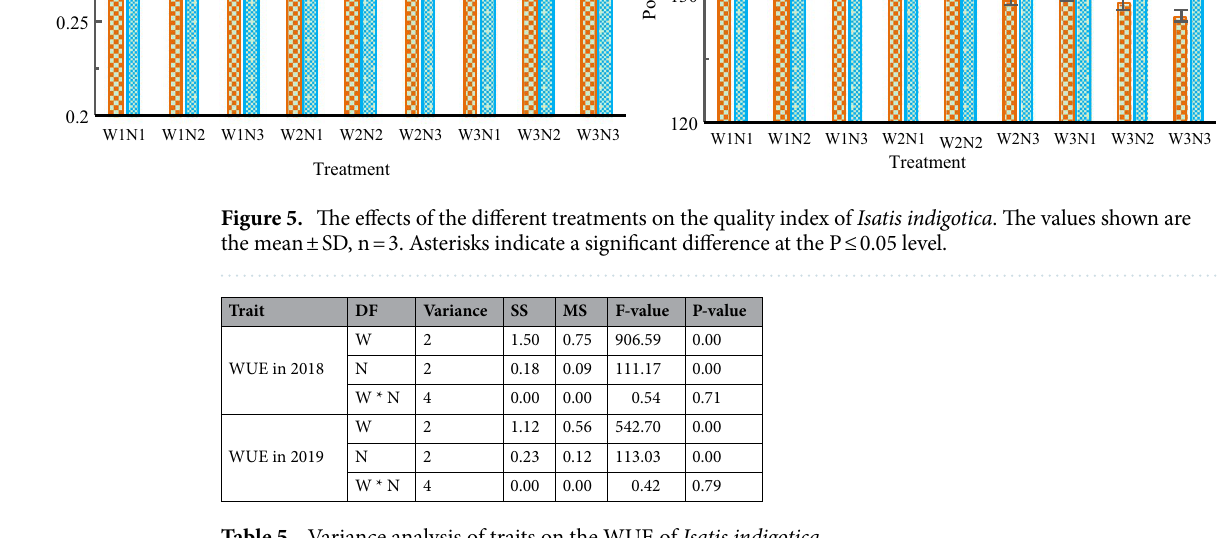
Table 5. Variance analysis of traits on the WUE of Isatis indigotica